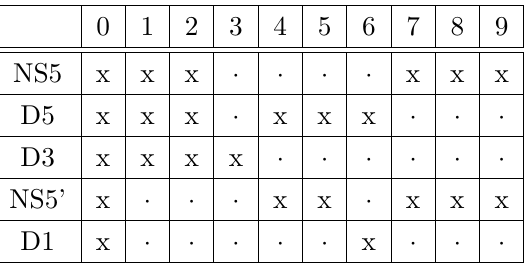
Table 3 . Type IIB brane construction for a vortex line